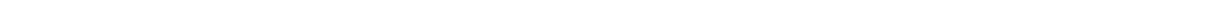
Fig. 7 The R2SP complex promotes the stabilization of its clients and the assembly of liprin- α 2 complexes. a R2SP enhances expression of some of its clients. The graph depicts the relative expression levels of the indicated FFL-fusion proteins in HeLa cells expressing PIH1D2, vs. parental HeLa cells not expressing it. Dark blue: experiment performed at 37 °C; light blue: experiment performed at 32 °C. Values are normalized by the mean of controls (left); error bars: standard deviation. ** p -value < 0.02 with a t -test involving all the control samples ( n > = 3). b Binding of PPFIA2-related proteins to SPAG1 and PIH1D2. The graph depicts LUMIER interaction assays between the indicated proteins. Error bars: standard deviation. Stars: values signi fi cantly greater than six-times the mean value obtained in the control IPs without anti-FLAG antibody (Ct). * p -value < 0.05; ** p -value < 0.001 (Z-test). c R2SP promotes association of liprin- α 2 (PPFIA2) with its partners. The graph depicts LUMIER interaction assays between PPFIA2 and its partners, in HeLa cells expressing or not PIH1D2. Legend as in Fig. 3c, with single black stars indicating a p -value < 0.05, and double black stars a p -value < 0.001 (Z-test comparing values of the FLAG IPs with six-times the mean value obtained in the control IP). Orange stars: comparison of HeLa and HeLa-PIH1D2 cells. Error bars: standard deviation. * p -values < 0.05; ** p -values < 0.005 (T-test). d Assembly of liprin- α 2 complexes by